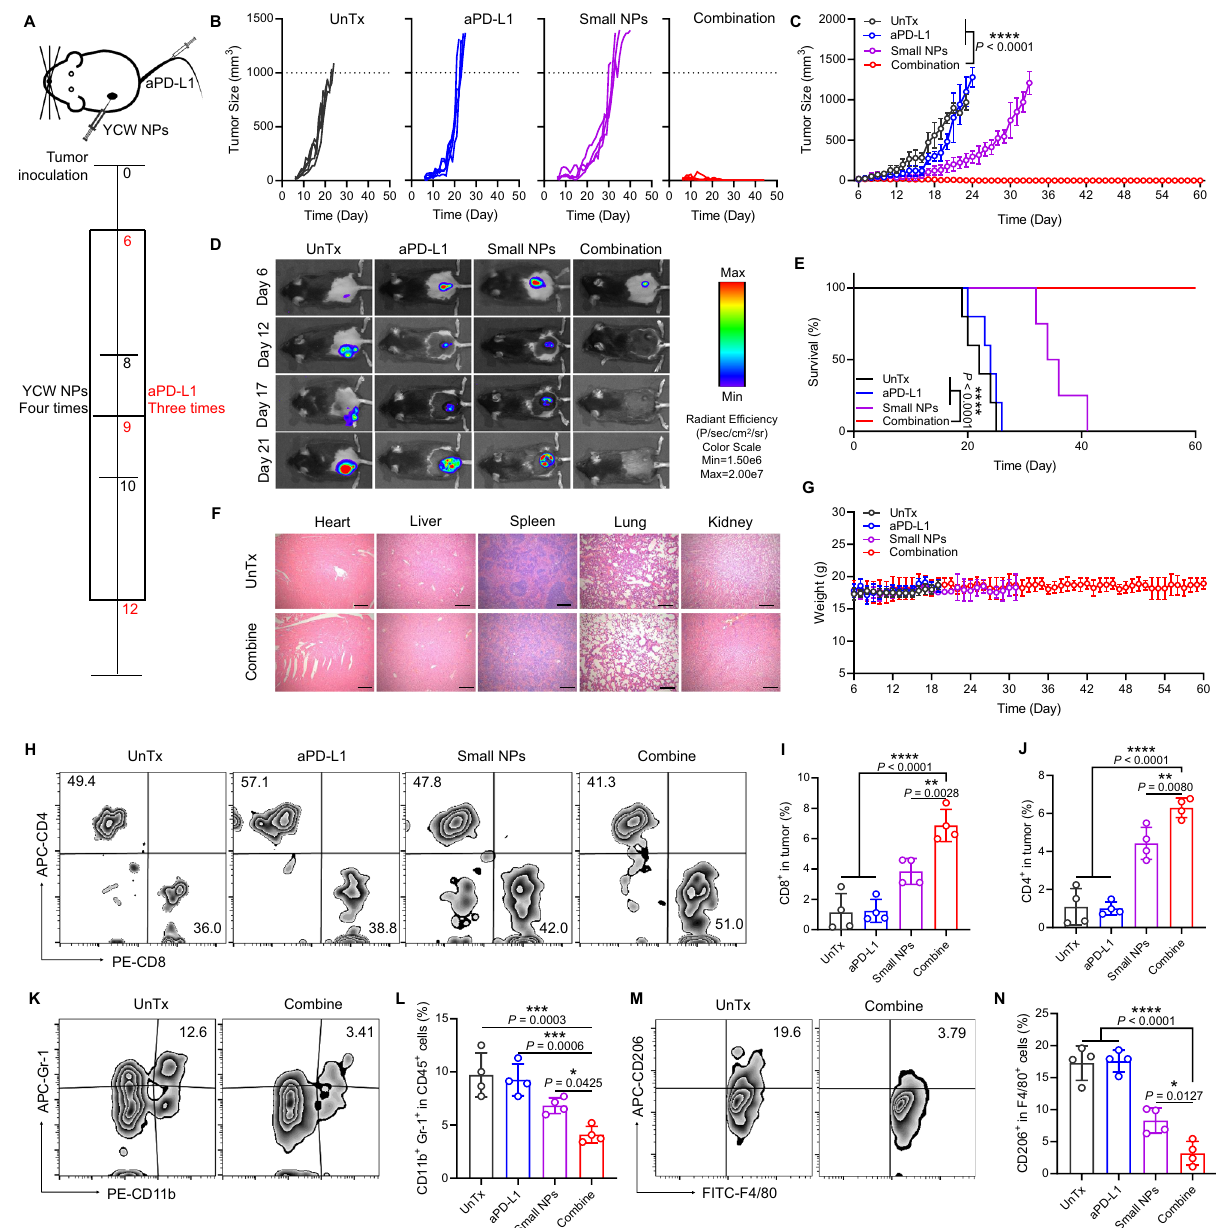
Fig. 6 Therapeutic ef fi cacy of YCW NPs in combination with PD-L1 blockade. A Schematic diagram of combination treatment, including UnTx group, aPD-L1 group, small NPs group, combination group. B – C Individual ( B ) and average ( C ) tumor growth curves in four groups (UnTx: n = 5; aPD-L1: n = 5; Small NPs: n = 4; Combination: n = 6) within 60 days. D In vivo bioluminescence imaging of B16-luc established mice in four different groups. E Survival curves of combination therapy. F Representative H&E staining imaging of main organs, including heart, liver, spleen, lung, kidney in group of untreated and combination (Scale bar = 200 µ m, n = 3). G Weight curve of different groups. H Flow cytometry plots of CD4 + T cells and CD8 + T cells of tumors in four groups. I Corresponding quantitative analysis of CD8 + T cells of tumor. J Corresponding quantitative analysis of CD4 + T cells of tumor. K Flow cytometry plots of MDSCs (CD45 + CD11b + Gr-1 + cells) in untreated and combination group. L Corresponding quantitative analysis of CD11b + Gr- 1 + in CD45 + cells. M Flow cytometry plots of TAMs (CD206 + CD11b + F4/80 + CD45 + cells) in untreated and combination group; N Corresponding quantitative analysis of CD206 + in CD11b + F4/80 + CD45 + cells ( n = 4). Statistical signi fi cance between combination group and other groups was obtained by one-way ANOVA using the Tukey post-test. **** P < 0.0001; *** P < 0.005; ** P < 0.01. Data are means ± SD.